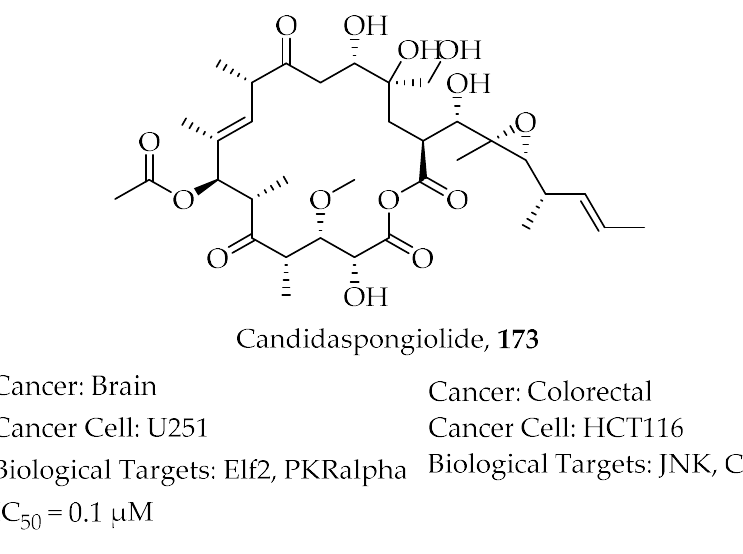
Figure 43. Structure of the polyketide Candidaspongiolide with a summary of its biological activity towards selected cancer targets.